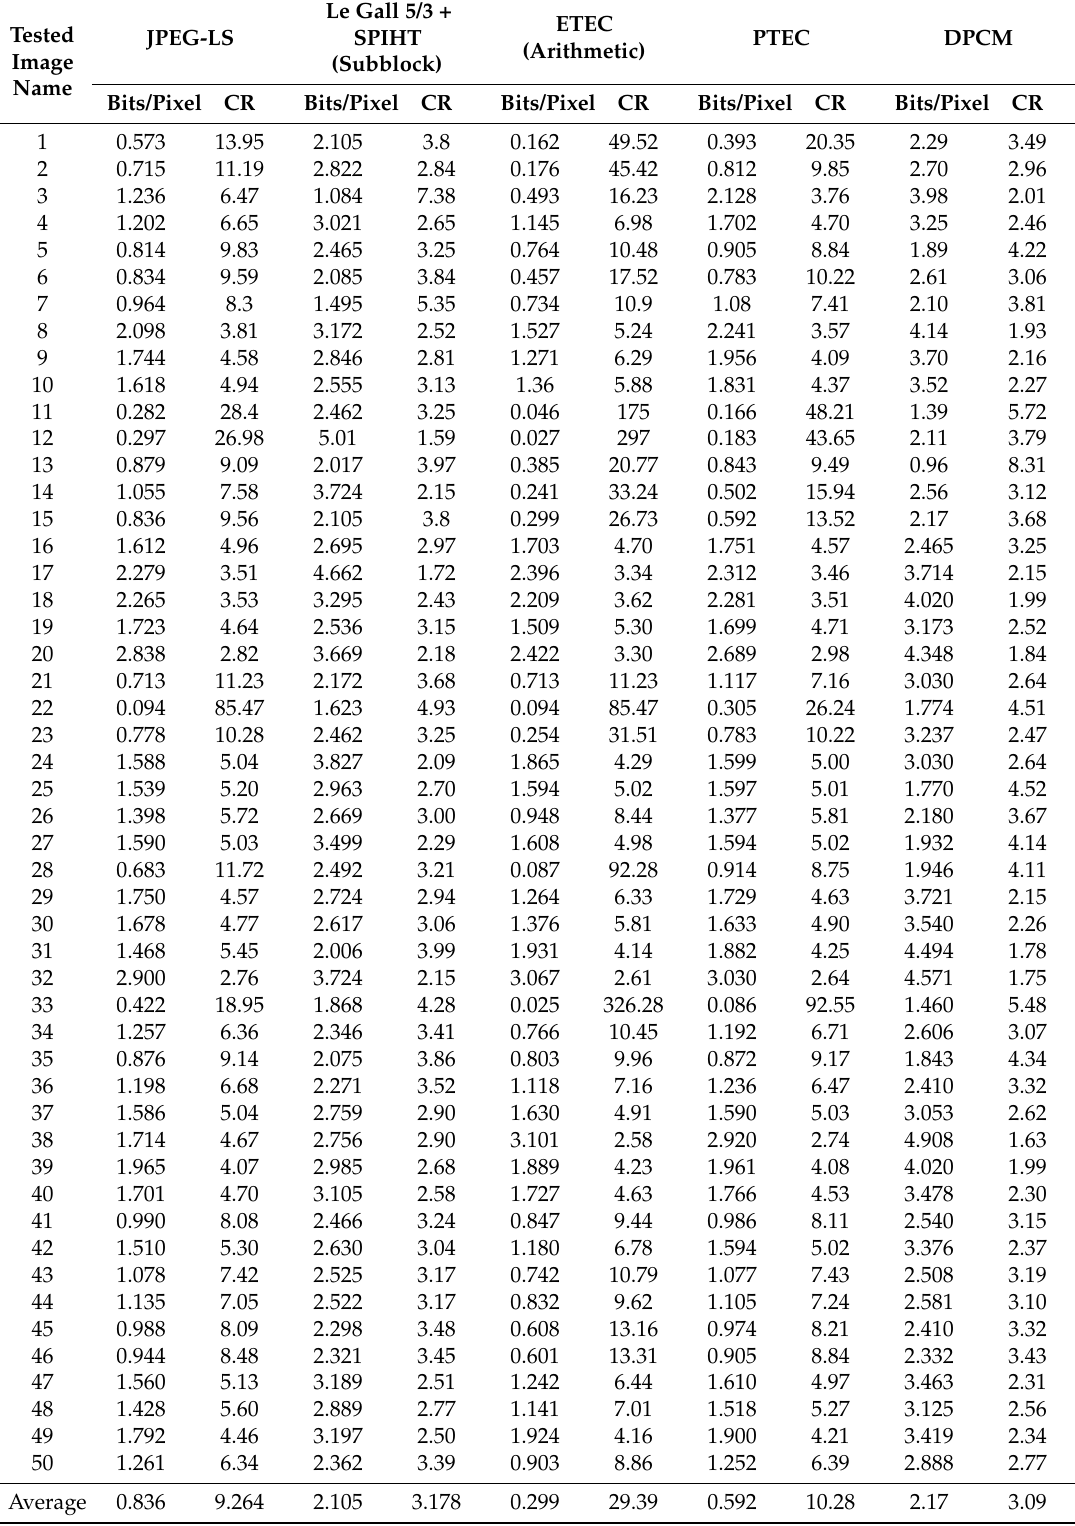
Table 2. Comparison of bits per pixel and compression ratio for pixelated